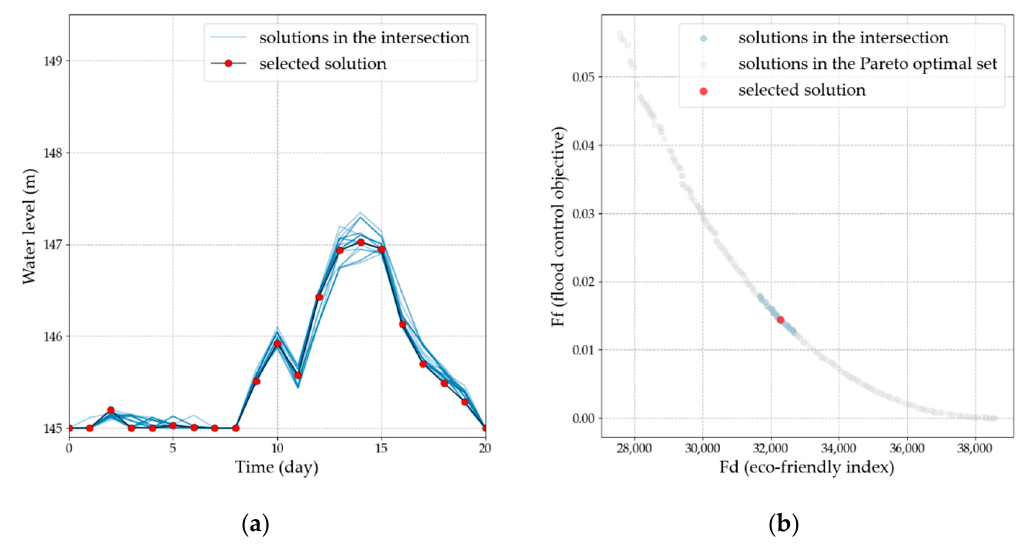
Figure 11. Results of the clustering-based method for solution selection (CMSS) considering the MWFSM-DPC method. ( a ) Reservoir operation processes in decision space; ( b ) objective values in objective space.